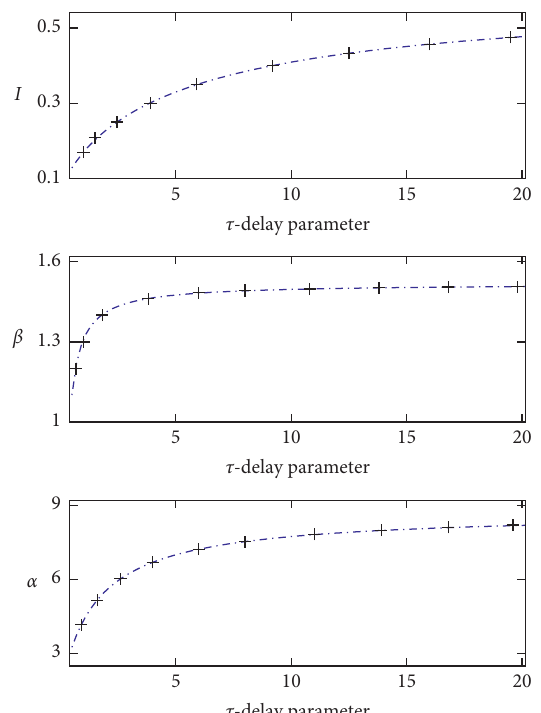
Figure 1: The regions produced by the Hopf bifurcation curves for the delay parameter τ versus I, β , and α . The analytical outcomes are indicated by the blue dashed lines, while the numerical simulation results for the PDE model are indicated by black